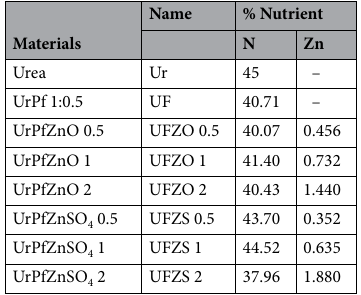
Table 2. List of named composites with their final composition.